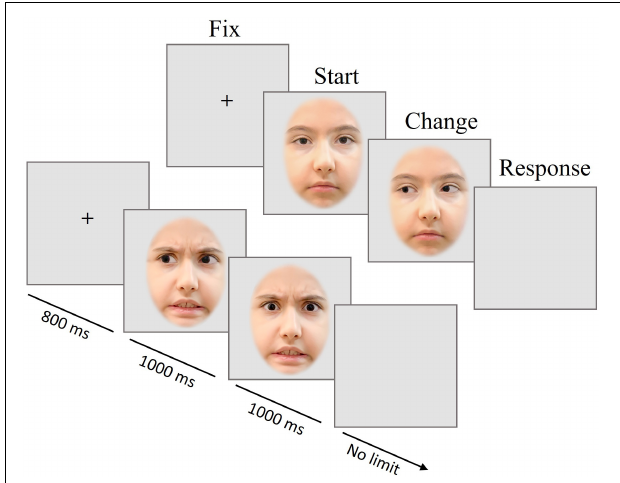
FIGURE 1 | Trial scheme of Experiment 1. Presentation of the fixation cross (FIX) for 800 ms, followed by the first picture with one of two emotional expressions and one of three gaze directions (START) for 1 s, and (in most trials) the gaze change (CHANGE) shown for 1 s; a blank screen prompted a button-press decision, whether a change had occurred or not (RESPONSE). The pictures are for illustration only and were neither taken from the CAFE database nor used in the